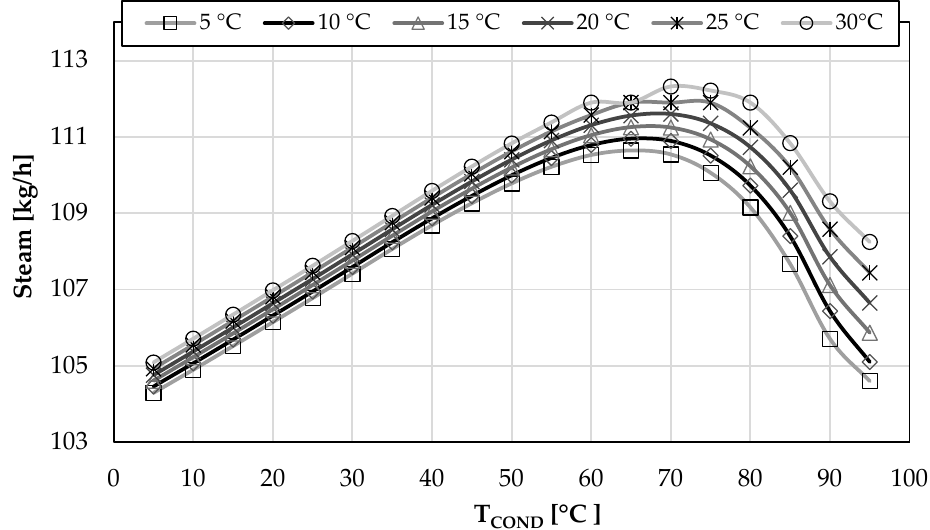
Figure 5. HRSG steam production as a function of the condenser working temperature (T COND ) varying the freshwater temperature from 5 °C to 30 °C.